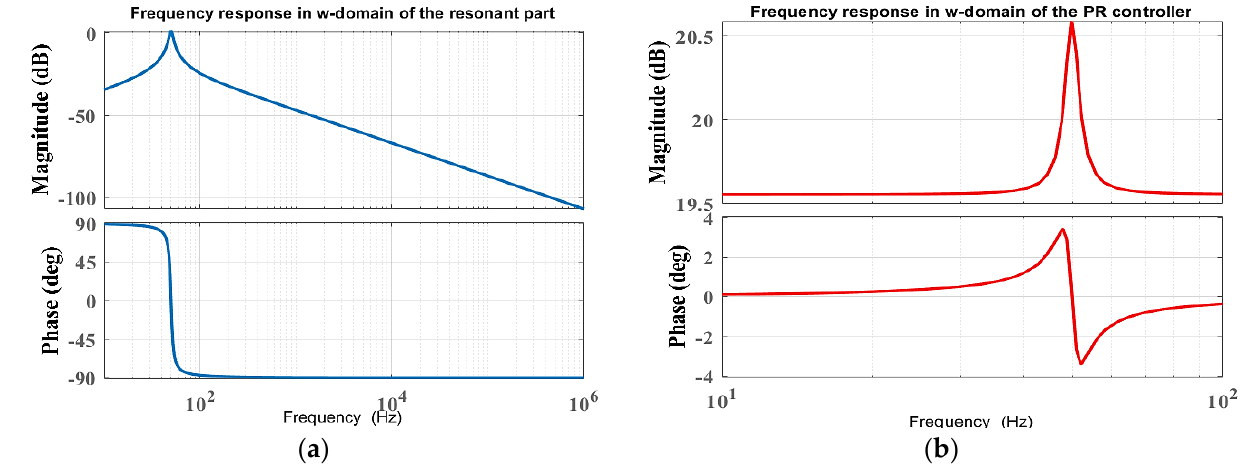
Figure 7. The magnitude and phase response of the designed ( a ) resonance filter and ( b ) PR controller.